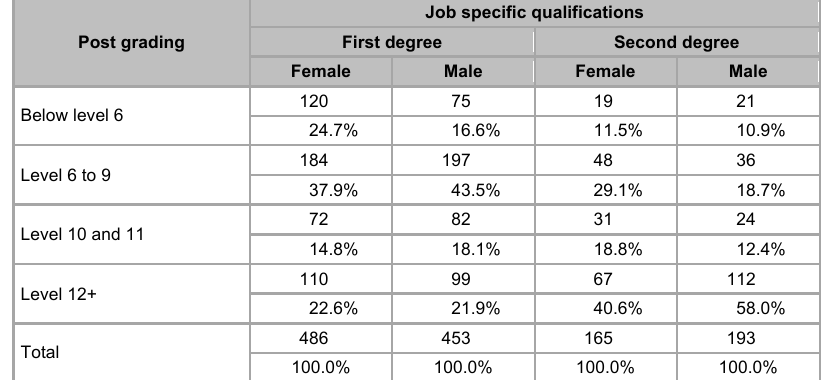
Gender and post grading by job specific qualifications: cross tabulation (count